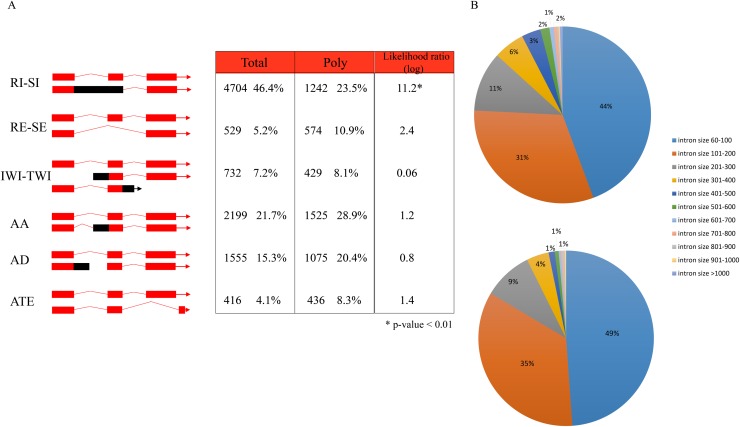
Different patterns of alternative splicing between total RNA-seq and polyribosomal RNA-seq.(A) Six classes of alternative splicing events in the two samples. RI-SI: retained intron or skipped intron. RE-SE: retained exon and skipped exon. IWI-TWI: initiation within intron or termination within intron. AA: alternative acceptor. AD: alternative donor. ATE: alternative terminal exon. G-test was used to calculate likelihood ratio statistics. (B) Distribution of retained intron sizes predicted by PASA in total RNA-seq (top circle) and polyribosomal RNA-seq (bottom circle).